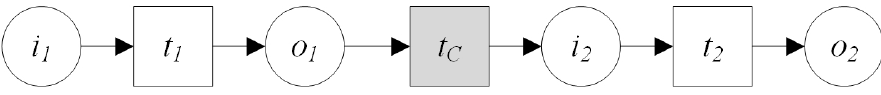
Figure 8. Sequential